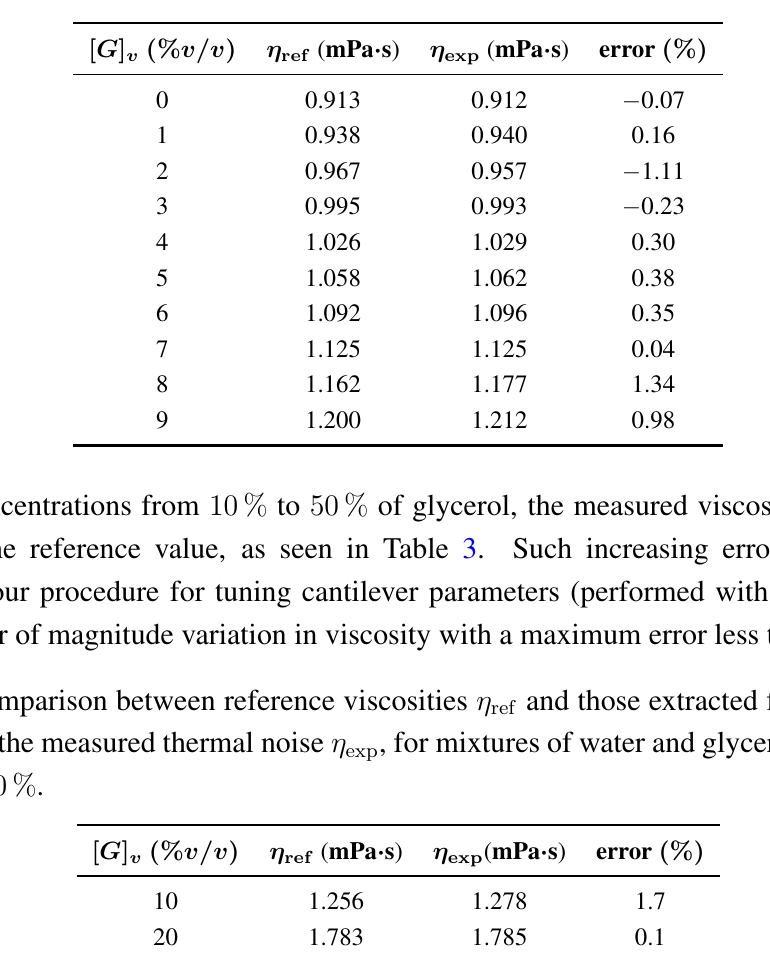
Figure 4. Experimental data (dots) and fits with Sader’s model (dashed lines) for the PSD of thermal noise-induced deflection for pure water (mQ) and a solution of 50% of glycerol. Table 2. Comparison between reference viscosities η and those extracted from the fits of ref the PSDs of the measured thermal noise η , for mixtures of water and glycerol in the range exp of zero to 10 % .